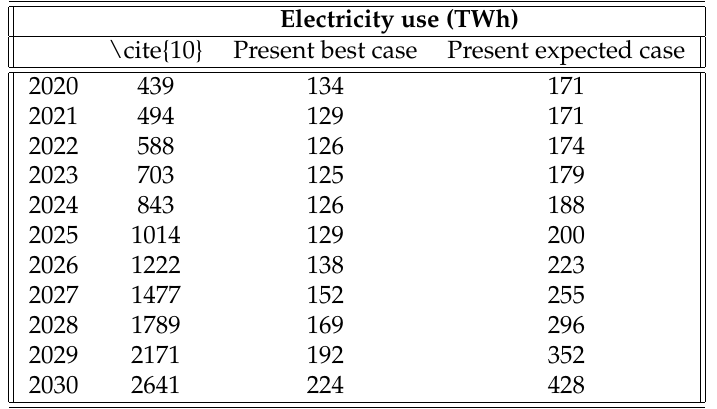
Table 4. Differences between [3] expected case and the present prediction for fixed access wired